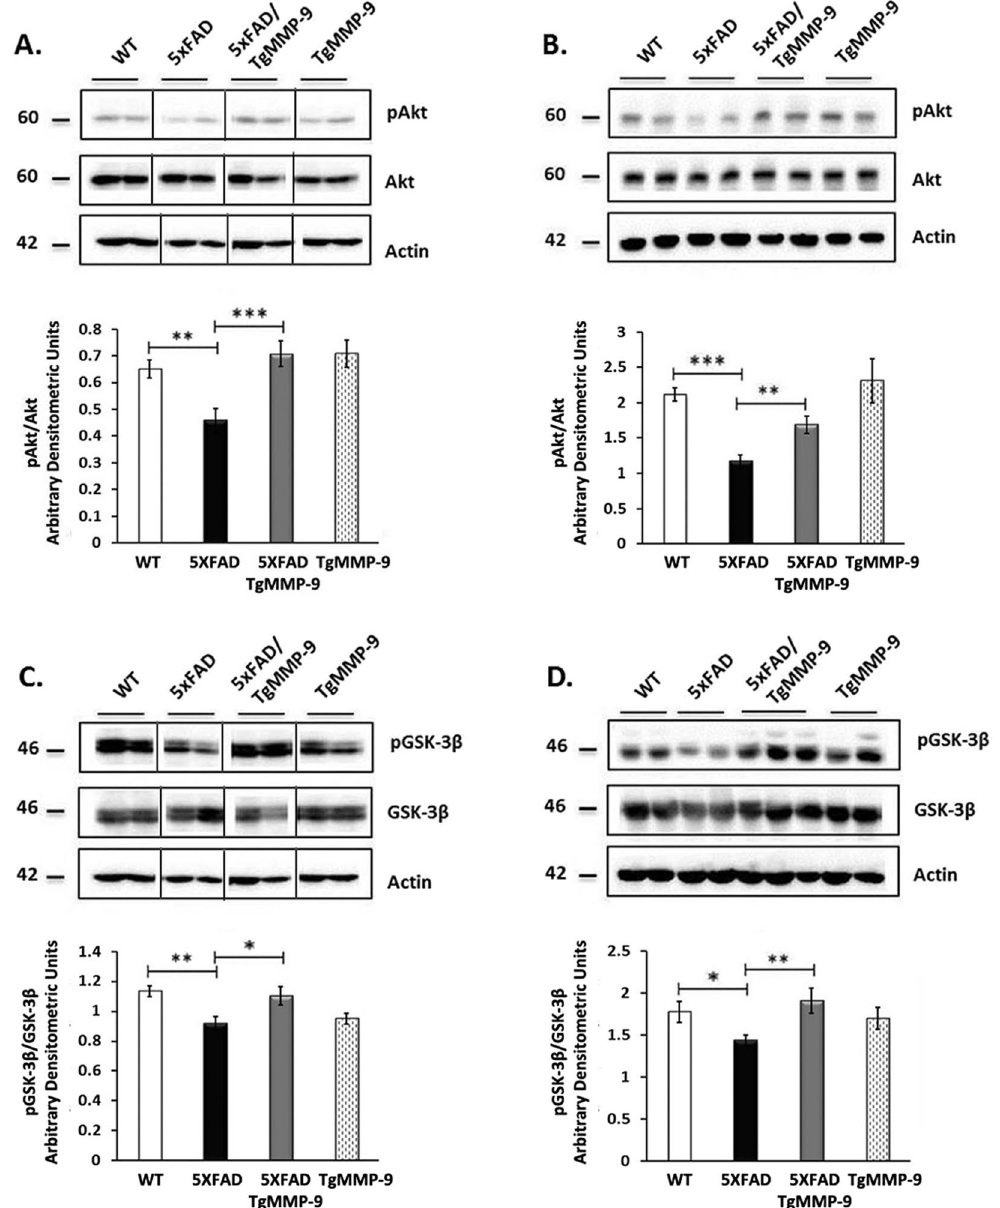
Figure 3. Representative Western blots of protein samples from primary hippocampal cell lysates ( A , C ) and hippocampal homogenates from 3 month-old mice ( B , D ) of WT, 5XFAD, 5XFAD/TgMMP-9 and TgMMP-9 mice. Equal amounts of total protein were analysed on 7.5% SDS-PAGE gels and immunoblotted with primary antibodies against pAkt and Akt ( A , B ), pGSK-3 β and GSK-3 β ( C , D ). To ensure equal loading, membranes were re-probed against β -Actin. Graphs depict densitometric quantification of phosphorylated proteins normalized to their respective total protein levels. n = 15–20 ( A ), n = 8–11 ( C ), n = 6–15 ( B ), n = 6–14 ( D ). All data are presented as mean ± SEM ( * p < 0.05, ** p < 0.01, *** p < 0.001). Lanes were run on the same gel but were noncontiguous. Full-length images are presented in the Supplementary